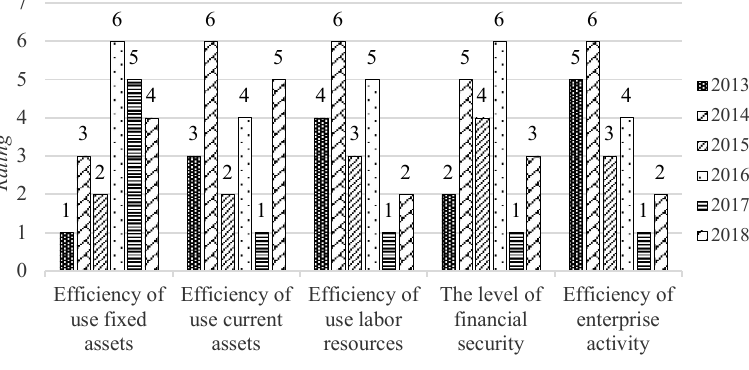
Fig. 2. The rating of years concerning the development level of PJSC «NKMZ» in the context of certain areas of its performance assessment